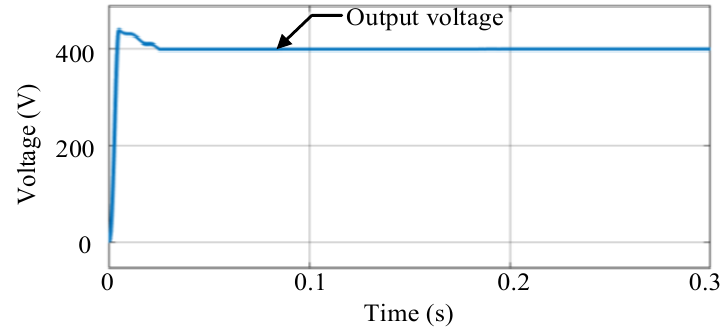
Figure 26. Output voltage of the rear stage.